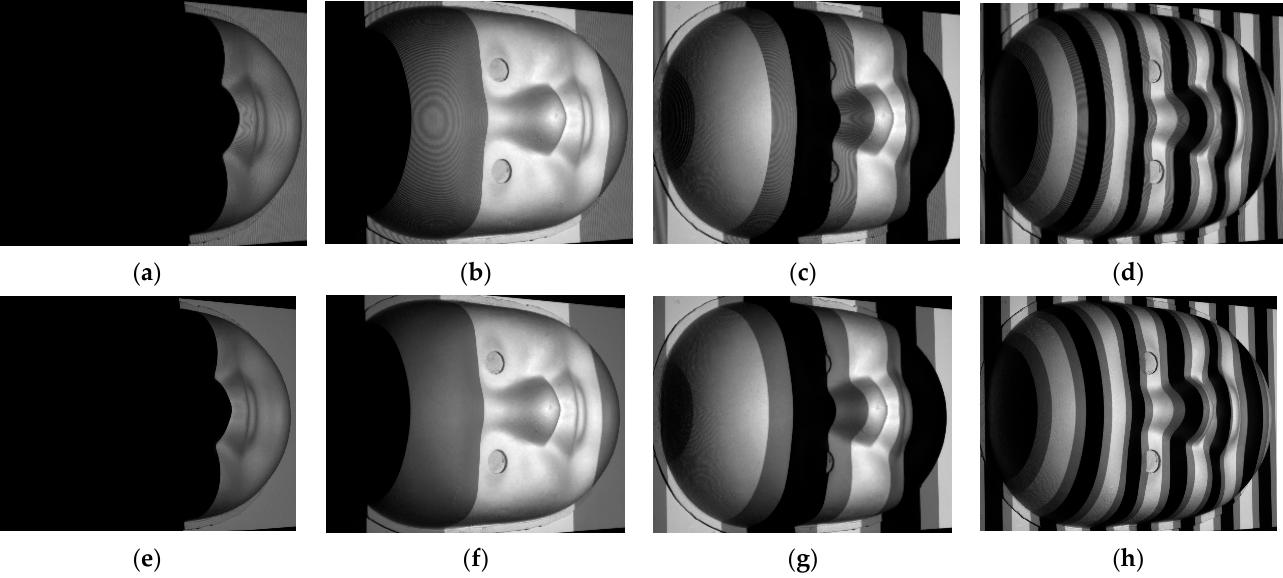
Figure 6. The four coding patterns when the projector is nearly focused, in which ( a – d ) are from the conventional ternary Gray-code method and ( e – h ) are from the improved Gray-code method.